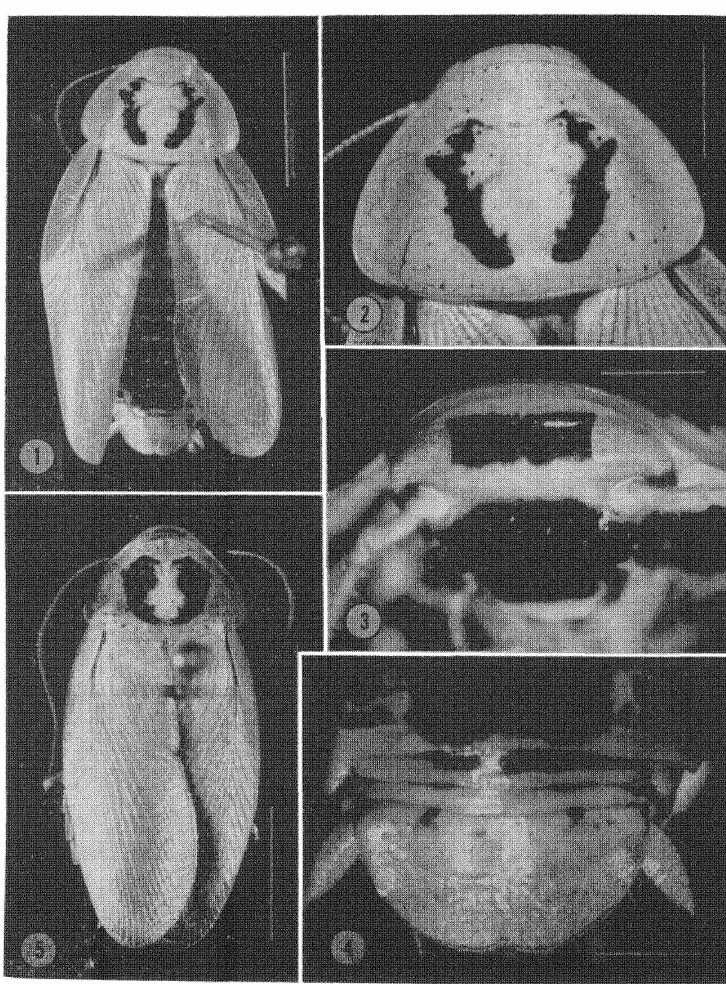
--- Figs. 1-5. Pinaconota bi[asciata. 1-4. Male, from Brazil. 2. Pronotum. 3. Head. 4. Terminal abdominal segments (dorsal). 5. Male from S. Cath., Brazil. (scale: figs. and ram; fig. 2 2 mm; figs. and 4--